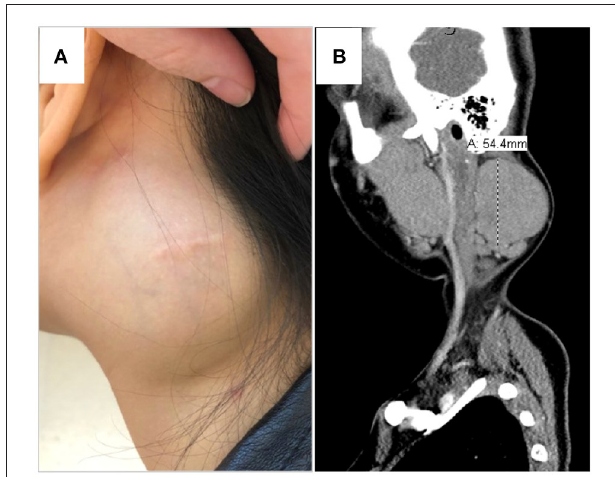
FIGURE 1 | Left neck mass. (A) Physical exam displayed a prominent, firm left neck mass, roughly 5 × 5cm, which was immobile, non-tender, non-fluctuant and marked by a healed surgical scar. She had an additional small, healed, post-auricular surgical scar. (B) CT scan demonstrated a 5.4 × 3.7 × 6.3cm, well-delineated, non-calcified, homogenous, non-necrotic nodal mass.